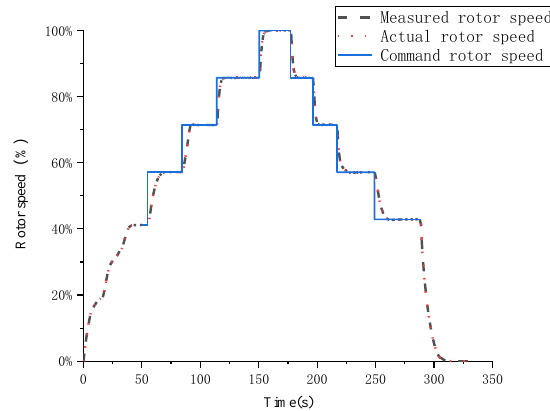
Figure 20. Full-digital simulation of rotor speed control.